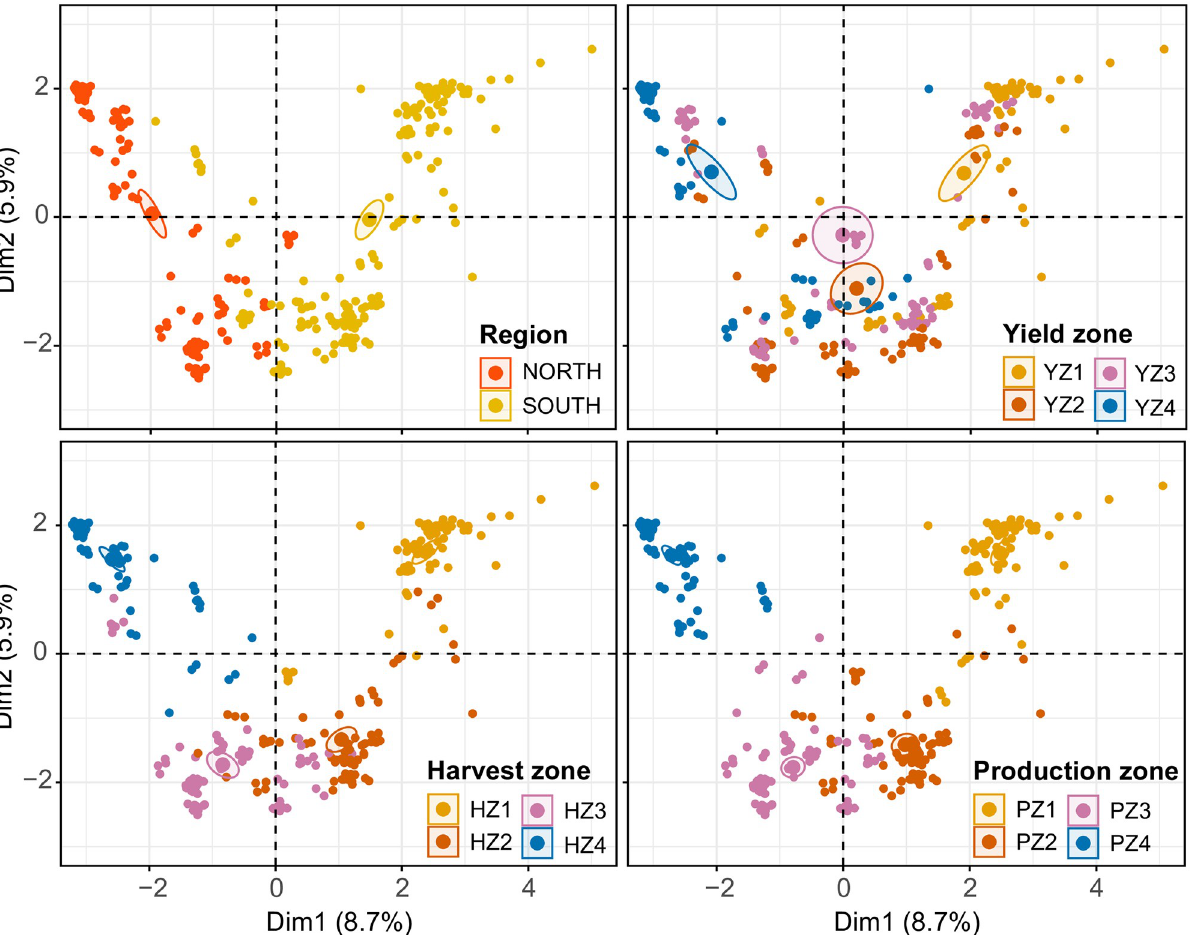
Fig 4. FAMD factor maps obtained from the factor analysis with mixed data approach (FAMD analysis), showing the variance maximizing distribution pattern of data points (n = 308, each data point represent foliar fungicide use in g/ha) in the map space with their clustering patterns based upon state (n = 28), year (n = 11), region (n = 2), and yield/harvest/production zones (n = 4 in each case). Yield/Harvest/Production zones = represent four levels (zone 1 to 4) based on the quartiles within a database containing 308 yield (kg/ha)/harvest area (ha)/production (MT) data points (308 = 11 years × 28 states). Within this database, data points from the minimum to the first quartile were classified as zone 1. Similarly, data points from the first quartile to median, median to the third quartile, and > third quartile were respectively classified as zones 2, 3, and 4. Foliar fungicides included: quinone outside inhibitors = azoxystrobin, fluoxastrobin, picoxystrobin, pyraclostrobin, trifloxystrobin; demethylation inhibitors = cyproconazole, difenoconazole, flutriafol, propiconazole, prothioconazole, tebuconazole, tetraconazole; methyl benzimidazole carbamates = thiophanate-methyl; multi-site mode of action = chlorothalonil; and succinate dehydrogenase inhibitors = fluxapyroxad (effective against anthracnose, Cercospora leaf blight (purple seed stain), frogeye leaf spot, Rhizoctonia aerial blight, Sclerotinia stem rot (White mold), Septoria brown spot, and soybean